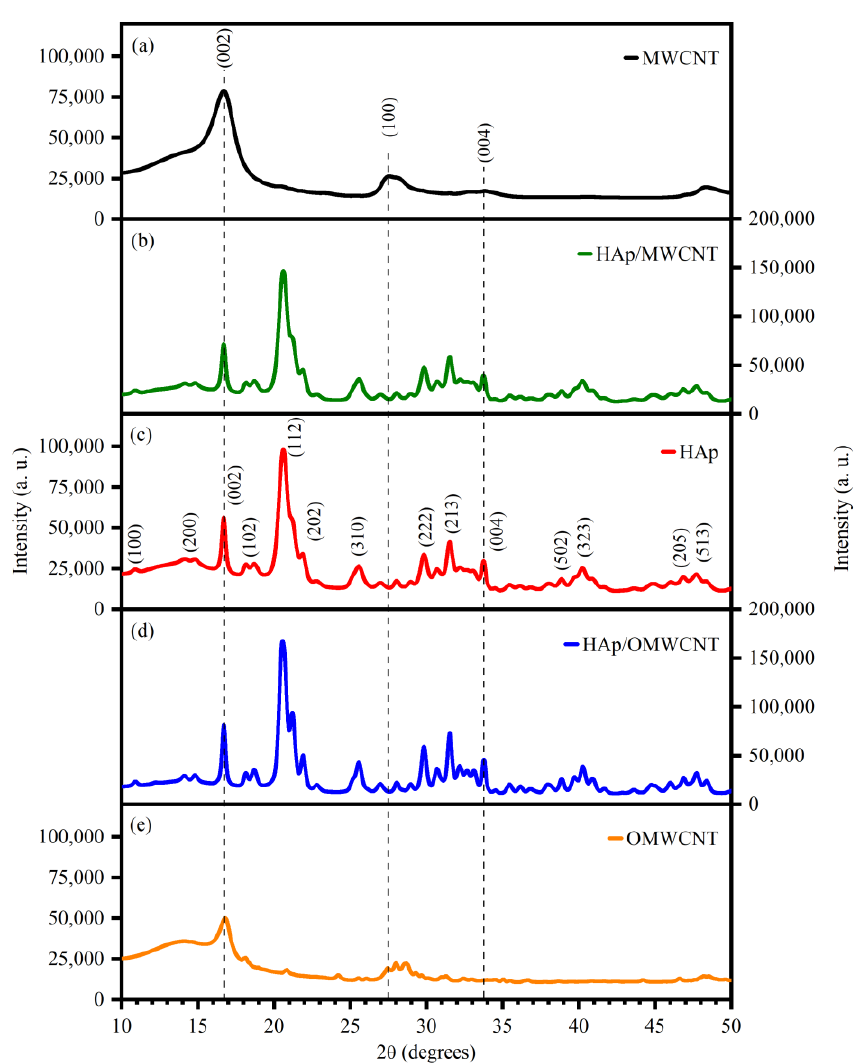
Figure 2. Diffraction patterns of the MWCNT ( a ), HAp/MWCNT ( b ), HAp ( c ), HAp/OMWCNT ( d ), and OMWCNT ( e ) samples. Vertical dashed lines indicate reflections associated with MWCNTs. Table 1. Results of the Rietveld analysis of HAp, HAp/MWCNT, and HAp/OMWCNT samples. The numbers in paren- theses denote the uncertainty in the last digit.